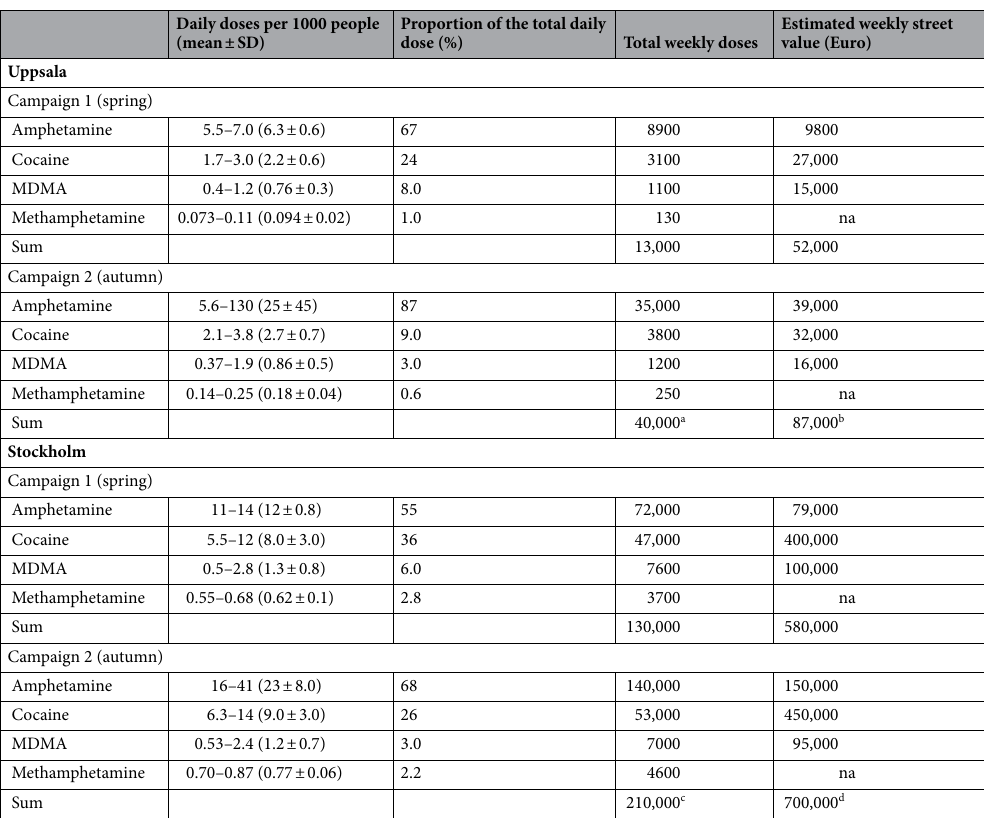
Table 4. Estimated drug doses and street values over the studied periods in Uppsala and Stockholm. Average dose 9 : 50 mg for amphetamine, 100 mg for cocaine, 100 mg for MDMA, 50 mg for methamphetamine. Average street price in 2019 53 : amphetamine, €1.1/dose; cocaine, €8.5/dose; MDMA, €14/dose. na: not available. Compared to data obtained in the campaign 1, the autumn’s estimated doses and values increased by + 204% a , + 67% b , + 57% c , + 20% d